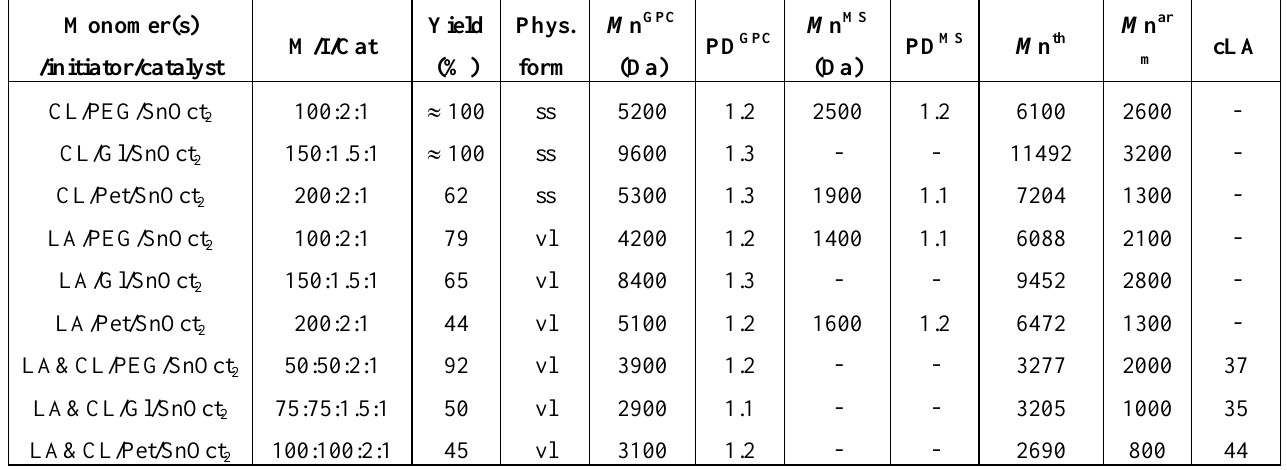
Table 1 . Homopolymerization and copolymerization of CL and LA in the presence of various initiators and SnOct 2